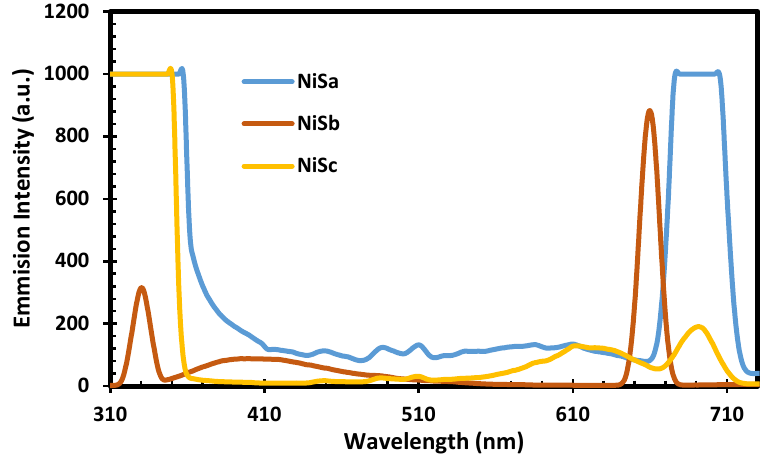
Figure 4. PL spectra for NiSa, NiSb, and NiSc nanoparticles.